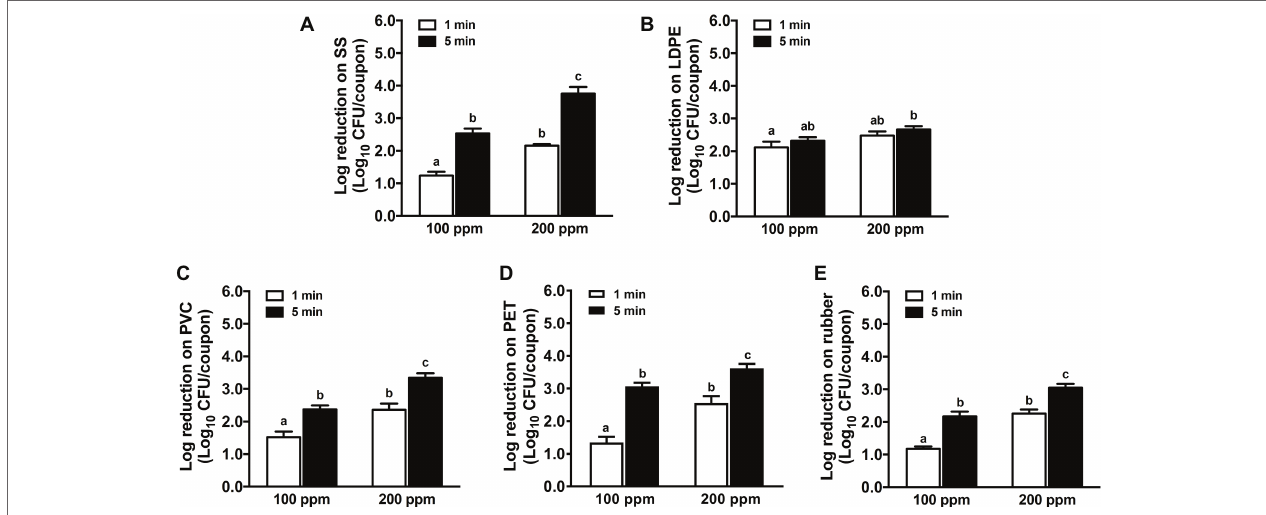
FIGURE 3 | Antimicrobial efficacy of chlorine against L. monocytogenes biofilms on food-contact surfaces. (A) Stainless steel (SS); (B) low-density polyethylene (LDPE); (C) polyvinyl chloride (PVC); (D) polyester (PET); (E) rubber. The 7-day-old biofilms on different surface coupons (15 mm × 7.5 mm) were treated with 100 or